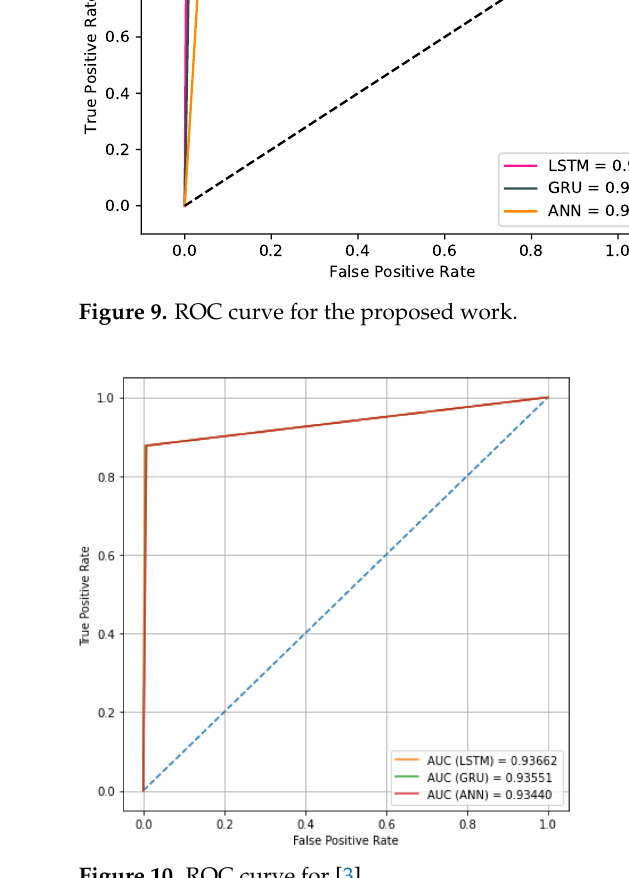
Figure 10. ROC curve for